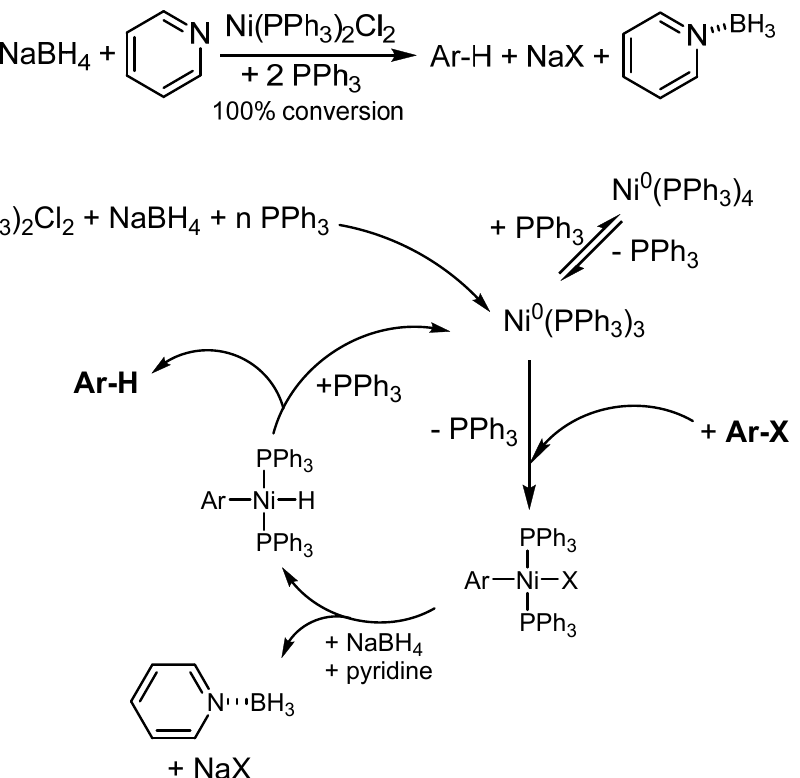
Figure 1. The structures of broadly used ligands of nickel complexes catalytically active for HDH [61–67].